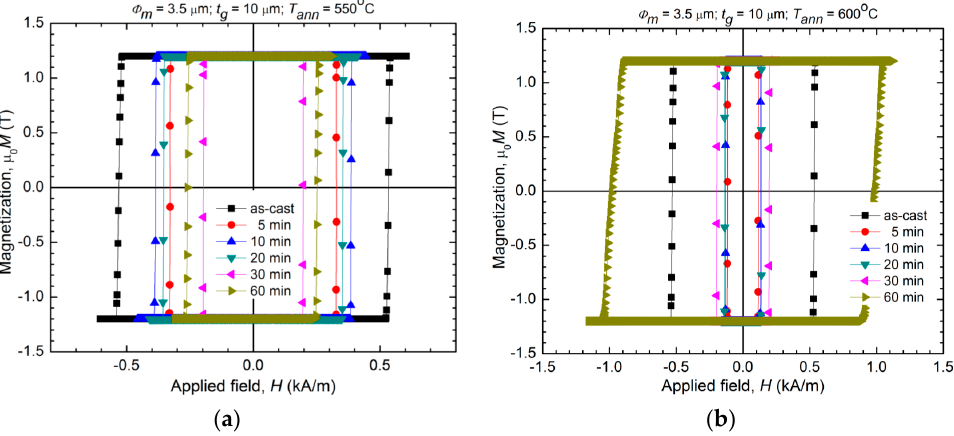
Figure 6. Axial hysteresis loops of a glass-coated Fe 73.5 Cu 1 Nb 3 Si 13.5 B 9 microwire with the metallic nucleus diameter of 3.5 μ m and the glass coating thickness of 10 μ m, with the annealing time as a parameter: ( a ) for an annealing temperature of 550 °C; and ( b ) for the annealing temperature of 600 °C.